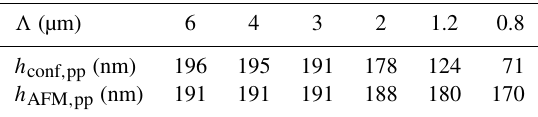
Table 2. Comparison of height differences depending on various spatial period lengths (cid:51) measured by AFM and confocal micro- scope using a RS-N standard manufactured by